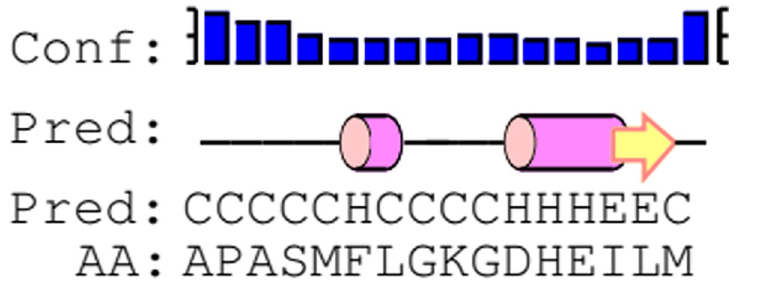
Fig 1. Secondary structure of Peptide 7.